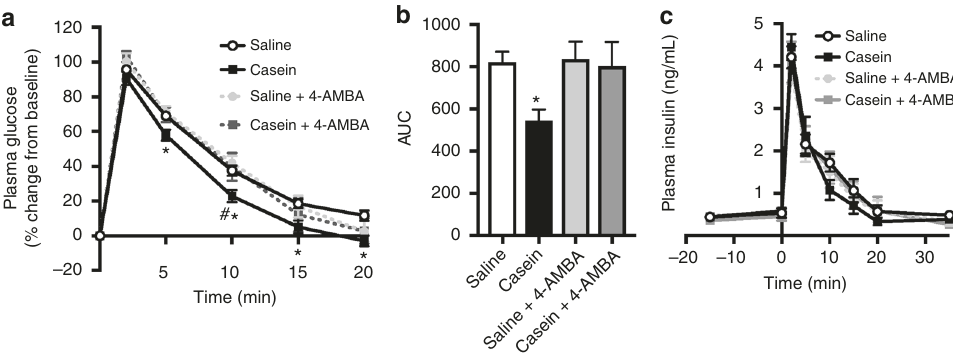
Fig. 2 Inhibition of peptide transporter 1 (PepT1) reverses the ability of casein infusion to increase glucose tolerance in healthy rodents. Percentage of change in plasma glucose levels ( a ), integrated area under the curve (AUC, b ), and plasma insulin levels ( c ) over time during the IVGTT for healthy rats that received an upper small intestinal infusion of saline ( n = 18), casein ( n = 24), saline + the competitive PepT1 antagonist 4-aminomethylbenzoic acid (4- AMBA, n = 7), or casein + 4-AMBA ( n = 6). Values are presented as mean ± s.e.m., where asterisk (*) represents p < 0.05 compared to saline control and hash ( # ) represents p < 0.05 compared to casein + 4-AMBA (assessed using ANOVA with Tukey